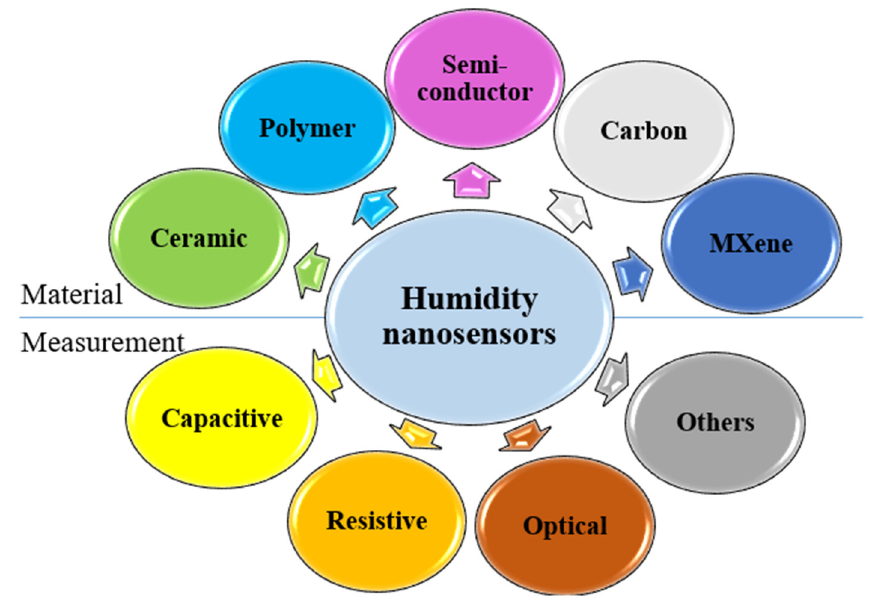
Figure 2. The materials and measurement types of humidity nanosensors.